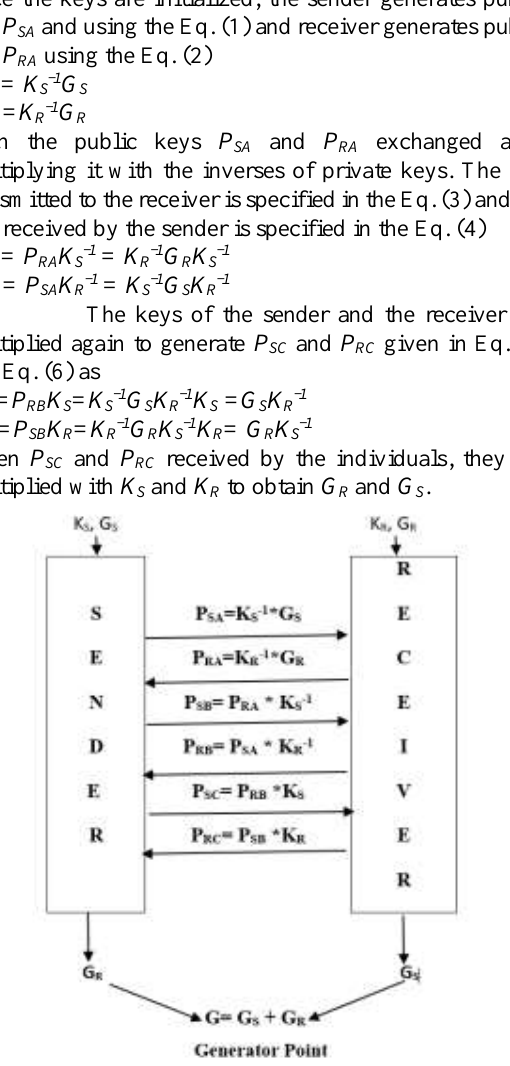
Figure 3 . Computational process for Generator